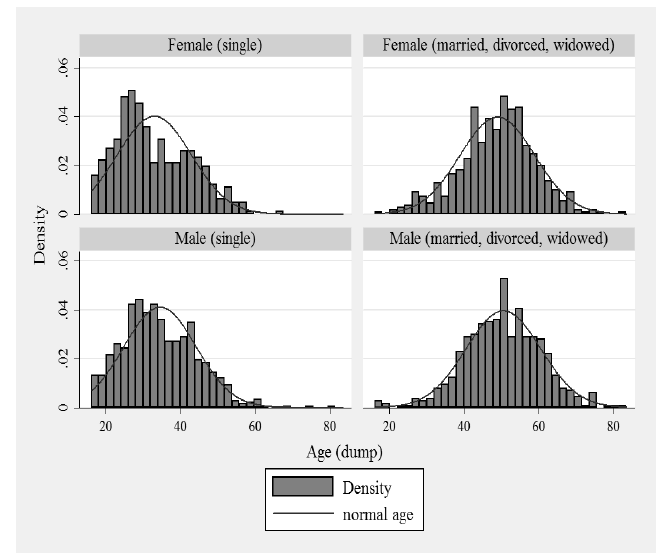
Figure 2 : Age distribution (kernel density) by sex and marital